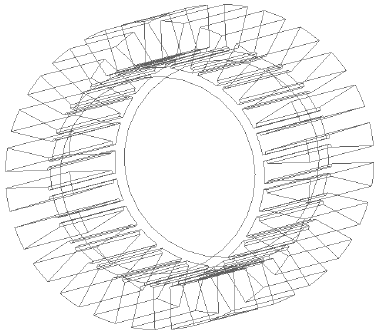
Energies 2022 , 15 , 4606 12 of 31 Figure 11. Finite element model for air friction with rotational speed. Figure 11. Finite element model for air friction with rotational speed.